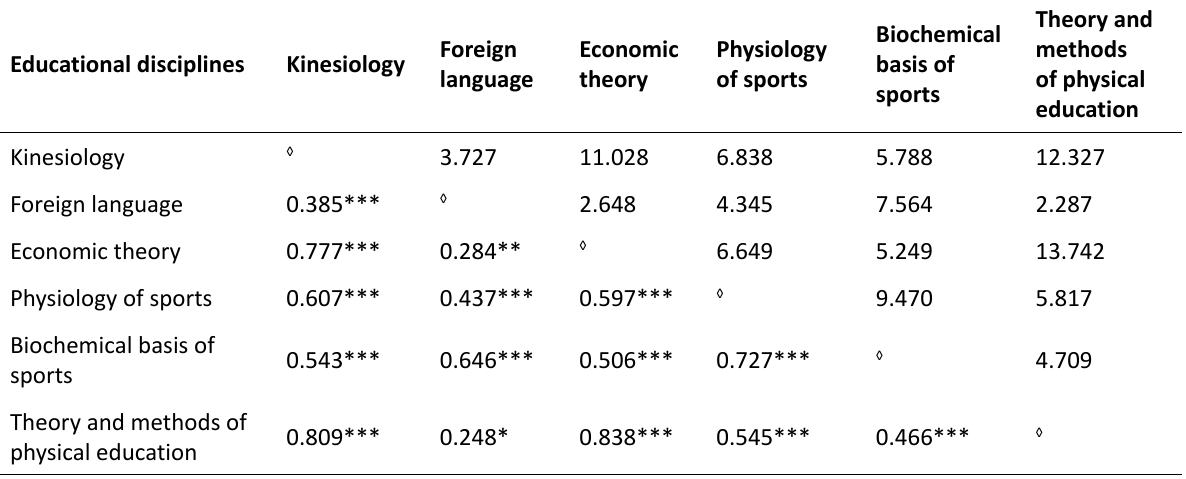
Table 5. Correlation table of the educational disciplines scores on the semester control of 3 rd year: r-Pearson \ t-Student